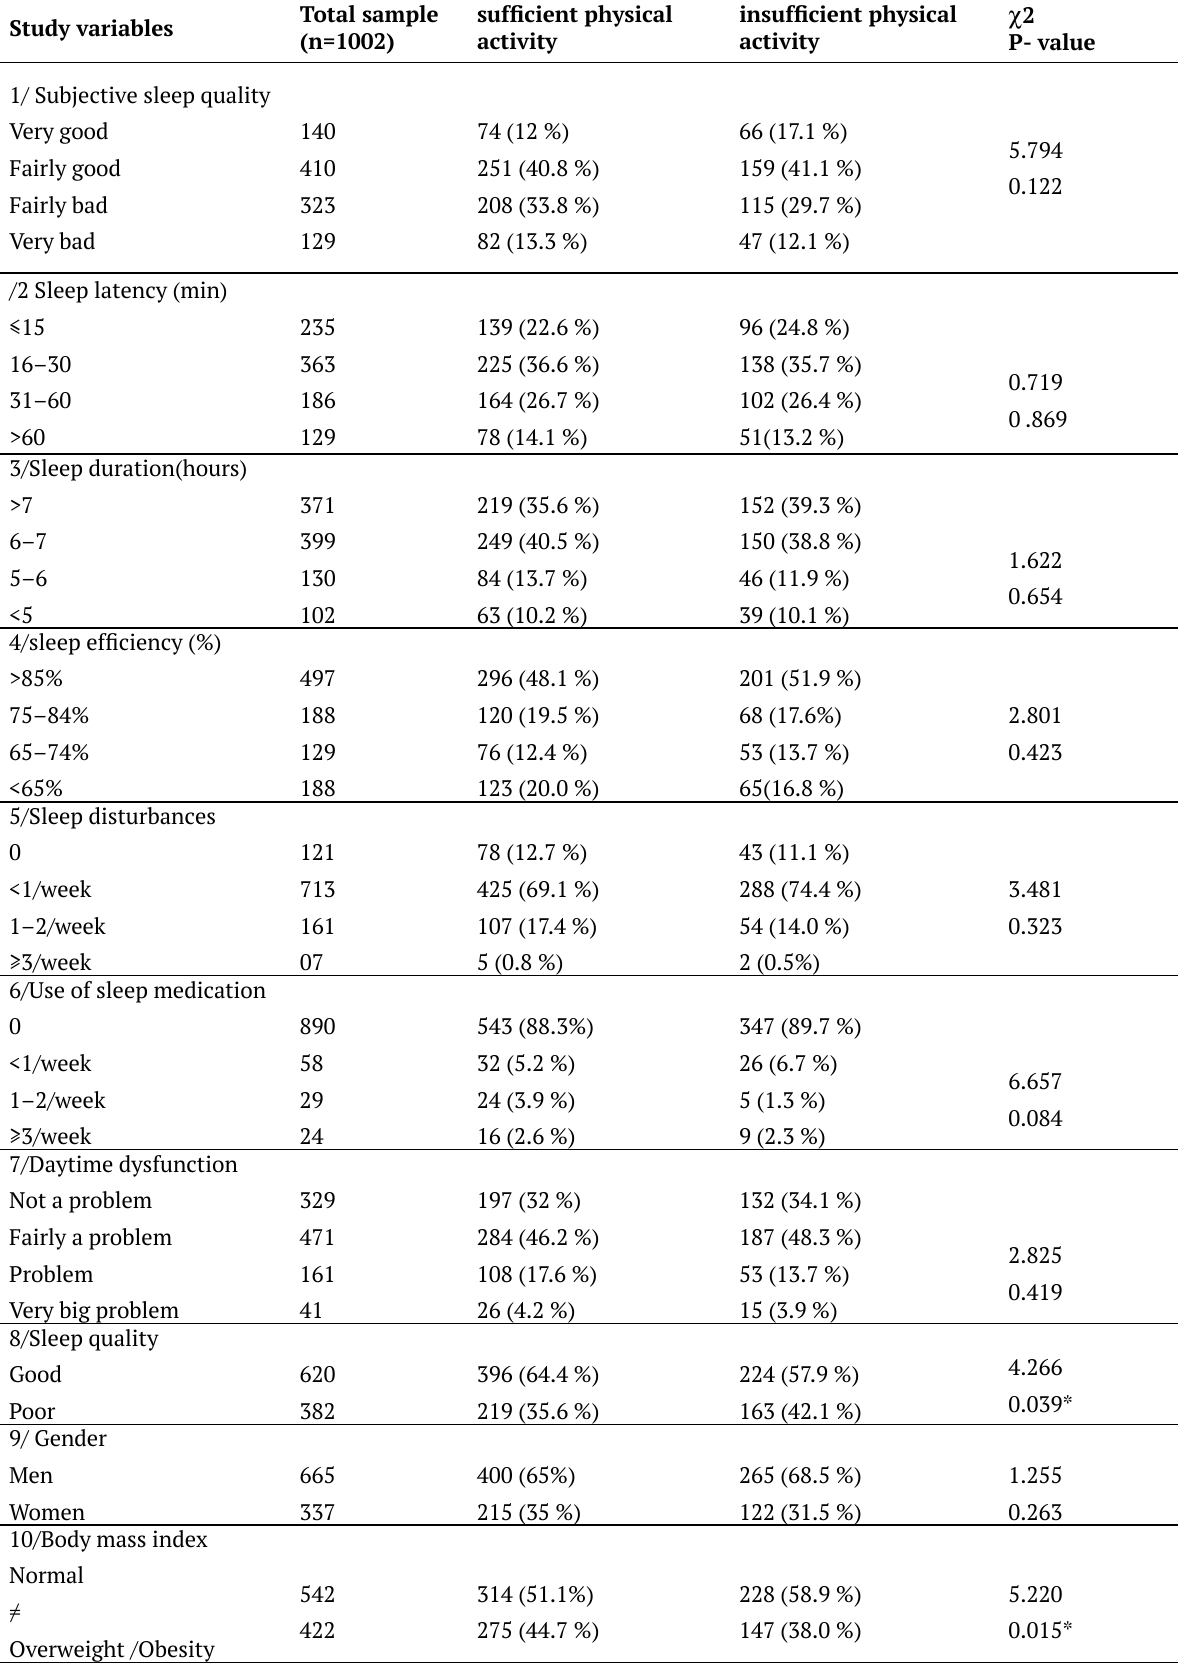
Table 3. Sleep quality index according to the level of physical activity in the study participants.